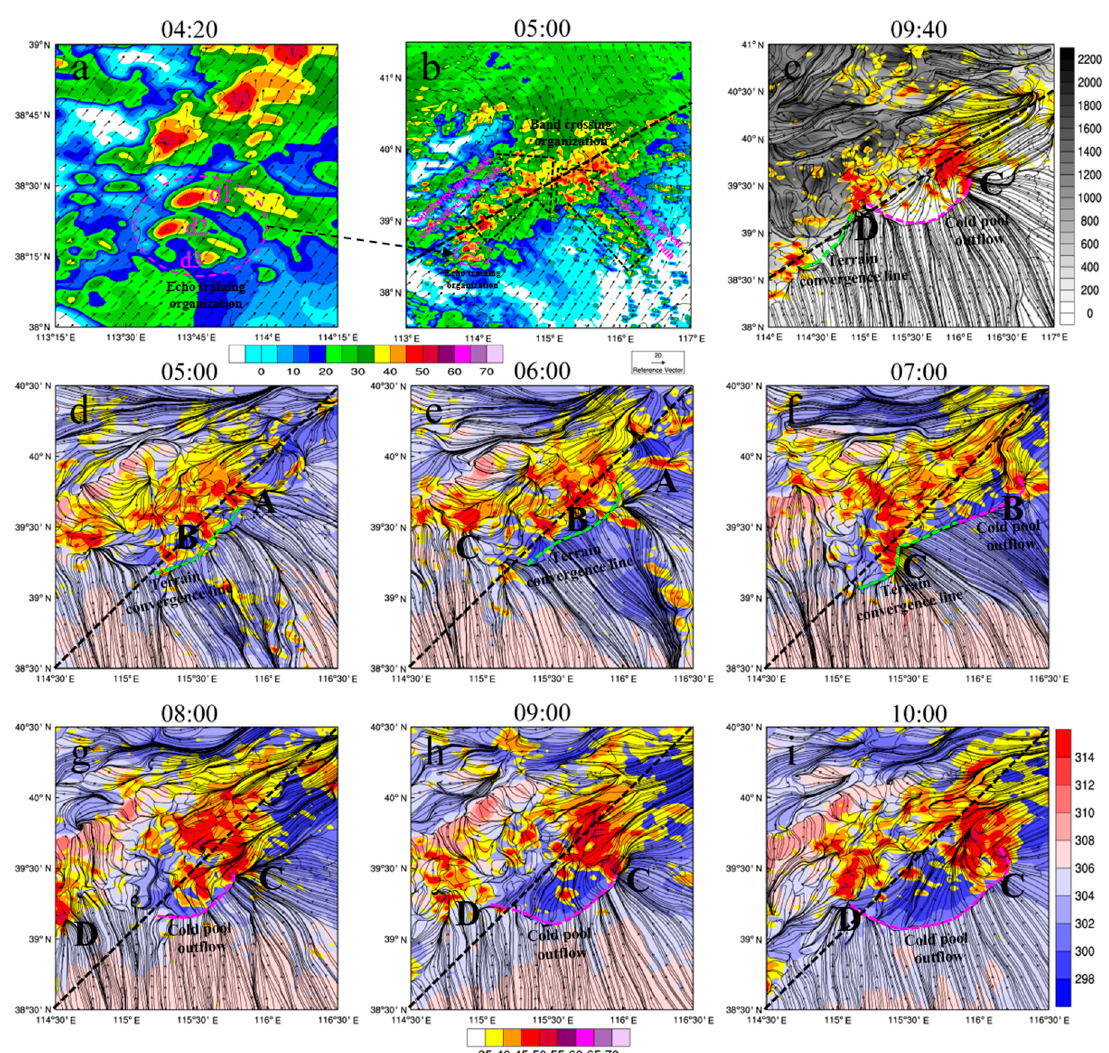
Figure 16. ( a, b ) Simulated composite radar reflectivity (shaded, units: dBZ) and the wind field (vector arrows, units: m s − 1 ) at 700 hPa at 0420 and 0500 UTC 21 July 2012, respectively. The magenta dotted ellipse in ( a ) denotes the echo-scale organization, and the two hollow arrows in ( b ) the band-scale organization. ( d – i ) Simulated composite radar reflectivity (shaded, units: ≥ 35 dBZ), the 2-m potential temperature (red and blue shaded, units: K) and the 2-m wind field (streamlines) at 0500, 0600, 0700, 0800, 0900, and 1000 UTC, respectively. The letters “A”, “B”, “C”, and “D” represent MCS-A, -B, -C, and -D, respectively. ( c ) As in ( d – i ) but for the topographic height (gray shaded, units: m). The green dotted lines denote the terrain convergence line. The magenta dotted line represents the outflow boundary of the surface cold pool. The black dotted lines roughly divide mountains and plains.